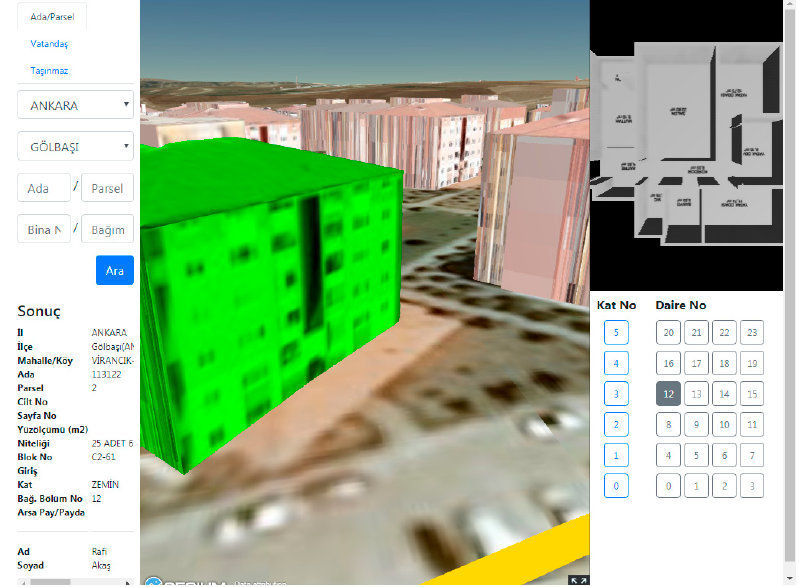
Figure 9. Visualization/querying of individual units with 3D cadaster prototype. Translation of some of the expressions: ‘Kat No’ = ‘Floor number’, ‘Daire No’ = ‘Individual unit Number’, ‘Sonuç’ = ‘Results’, ‘Ad’ = ‘Name’, ‘Soyad’ = ‘Surname’ [61].